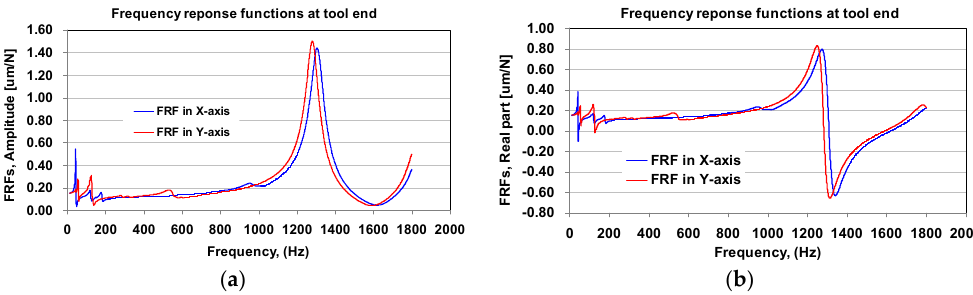
Figure 8. Comparisons of the predicted frequency response functions at tool end of milling machine modelin X and Y directions. ( a ) Amplitude of the FRFs, ( b ) Real part of the FRFs.